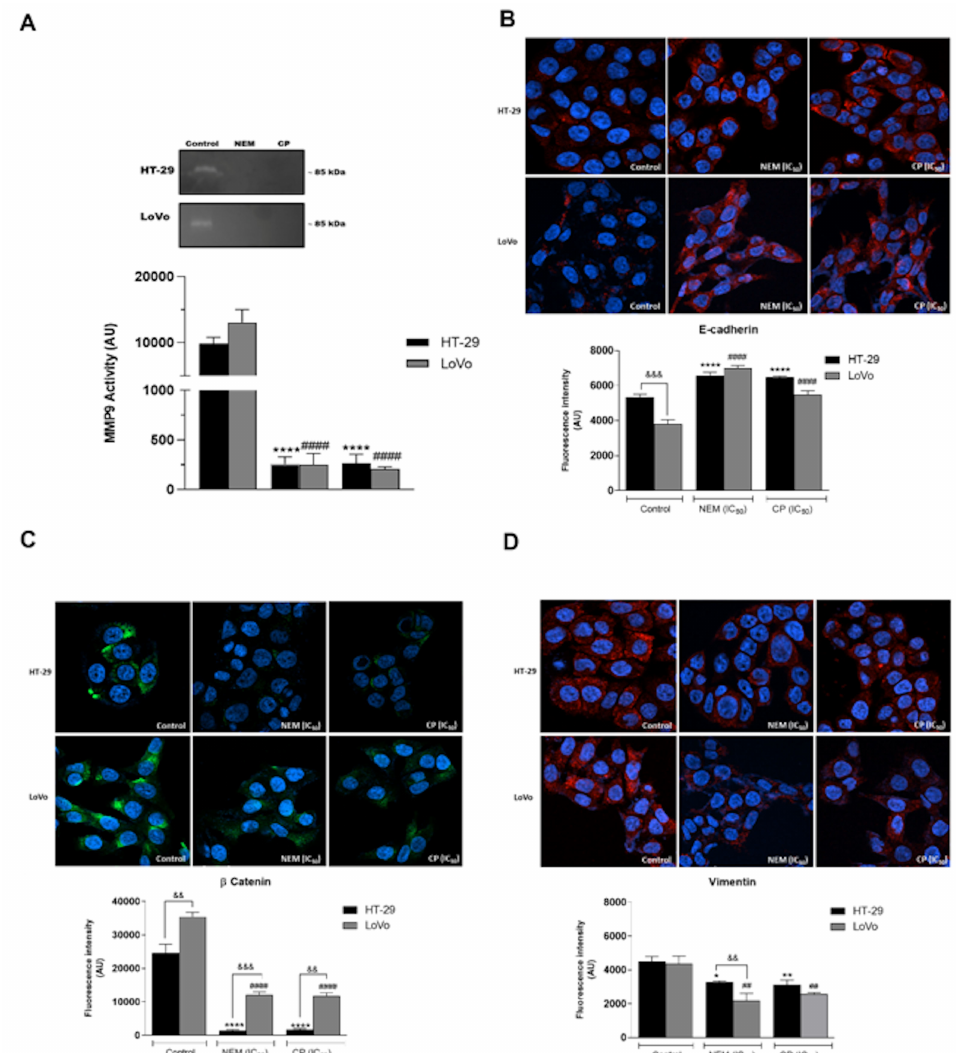
Figure 9. E ff ect of NEM and CP on proteolytic activity of MMP9 in CRC cells ( A ). E ff ect of NEM and CP (IC 50 / 72 h) on the expression of epithelial–mesenchymal transition (EMT)-related markers E-cadherin ( B ), β -catenin ( C ) and vimentin ( D ) in CRC cells. In immunocytochemistry (ICC) images, E-cadherin and vimentin are in red and β -catenin is in green. Nuclei were stained with Hoechst (blue). Magnification: 40 × . Data are reported as the mean ± SD of three independent experiments. ** p < 0.01, **** p < 0.0001 vs. untreated cells. LoVo cells: #### p < 0.0001 vs. untreated cells. && p < 0.01, &&& p < 0.001 vs. the other cell line treated with the same conditions. N.d: not